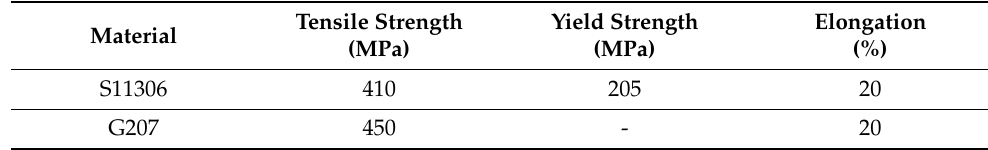
Table 2. Mechanical properties of S11306 ferritic stainless steel.